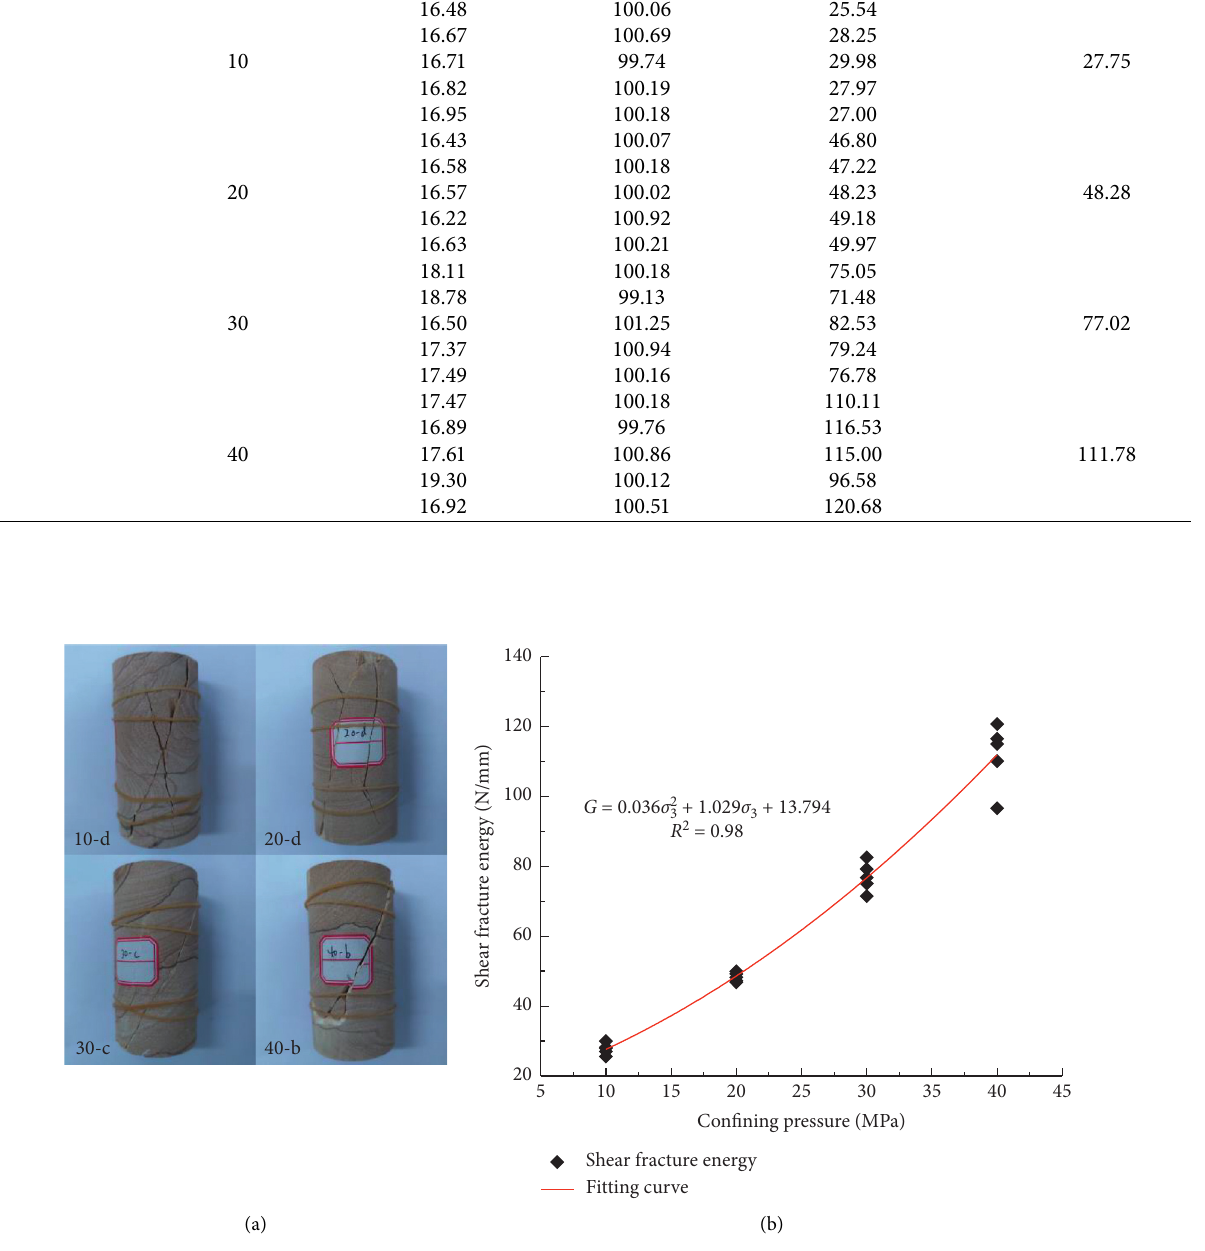
Figure 8: Failure of rock samples. (a) Failure diagram of rock samples under different confining pressures. (b) Shear fracture energy of rock samples under different confining